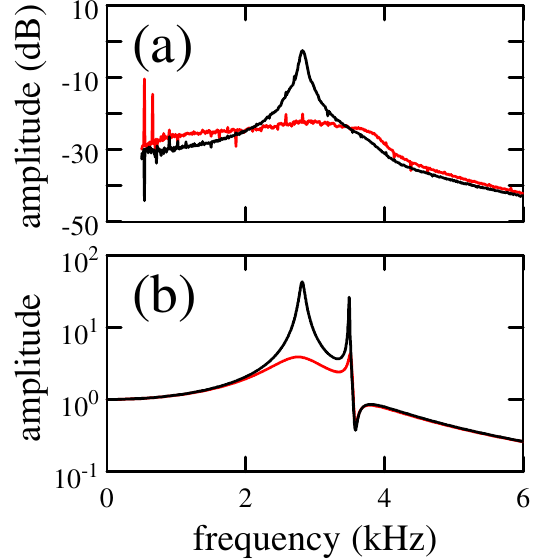
FIG. 10. (Color) Operation with passive harmonic-cavity volt- age equaling 119% of that required for optimal bunch length- ening. In this case, a double-hump bunch is confined in a synchrotron potential with two minima. Black curves: phase feedback off. Red curves: phase feedback on. (a) Experimental measurement of the transfer function phase shift. (b) Phase shift calculated with the beam energy spread equaling its natural